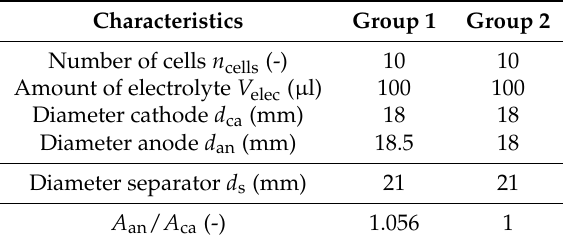
Table 5. Anode overhang investigation. Two different A an / A ca ratios are tested and declared as